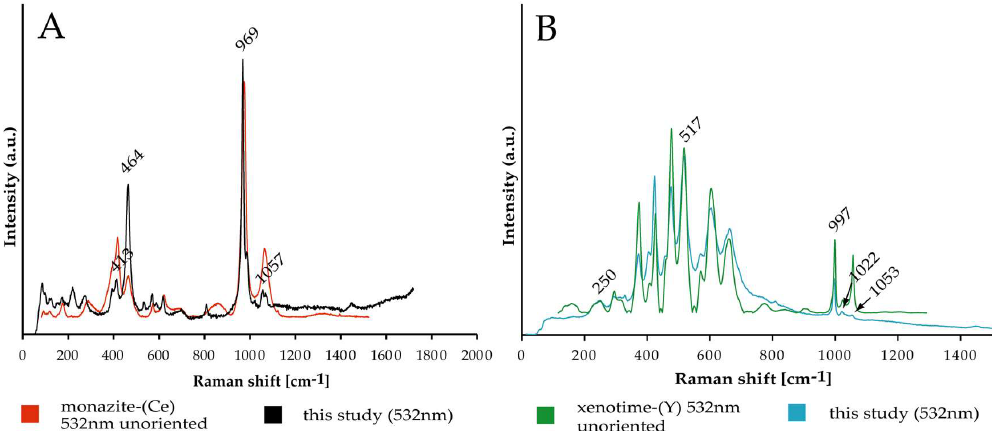
Figure 9. Representative Raman spectra of monazite-(Ce) and xenotime-(Y) grains recovered from heavy mineral concentrates of bauxitic ores of the CCR. ( A ) Monazite spectrum obtained with a 532 nm wavelength laser. ( B ) Xenotime-(Y) spectrum obtained with a 532 nm wavelength laser. Reference spectra for comparison in (A) and (B) were taken from [56]. a.u. = arbitrary units. The studied monazite-(Ce) and xenotime-(Y) grains have relatively low ThO 2 (av. =1.07 wt %; 0.014 atoms per formula unit, a.p.f.u., Th, normalized to 4 oxygens), UO 2 (av. =0.33 wt %, 0.003 a.p.f.u.) and CaO (av. =0.26 wt %) (Table 4) contents. Monazite-(Ce) shows systematically higher ThO 2 than xenotime-(Y) in which ThO 2 contents commonly lie below the detection limit (d.l.) for EPMA. MnO, BaO and SrO generally are below detection limit. SiO 2 , Al 2 O 3 , TiO 2 and FeO contents are mostly below 1 wt % and may, at least partially, be attributed to measurement errors due to the small grain sizes of the rare earth minerals. Ce (av. =0.43 a.p.f.u.) is the dominant REE in monazite grains along with less abundant La (av. = 0.2 a.p.f.u.), Nd (av. = 0.19 a.p.f.u.), Gd (av. = 0.04 a.p.f.u.) and Sm (av. = 0.03 a.p.f.u.). The dominant REE in xenotime-(Y) is Y (av. = 0.69 a.p.f.u.) along with minor Dy (av. = 0.06 a.p.f.u.), Er, Yb (both av. = 0.04 a.p.f.u.) and Gd (av. = 0.03 a.p.f.u.). Most EPMA analyses showed analytical totals ~100%, and approach near ideal stoichiometry (total A site cations equal ~0.93 and ~0.96 a.p.f.u. in monazite and xenotime, respectively and total B site cations equal ~1.16 and ~1.14 a.p.f.u.in monazite and xenotime, respectively). Table 4. Representative EPMA analyses of monazite-(Ce) (left) and xenotime-(Y) (right) grains in heavy mineral concentrates and thin sections of the bauxitic samples of the CCR. No.